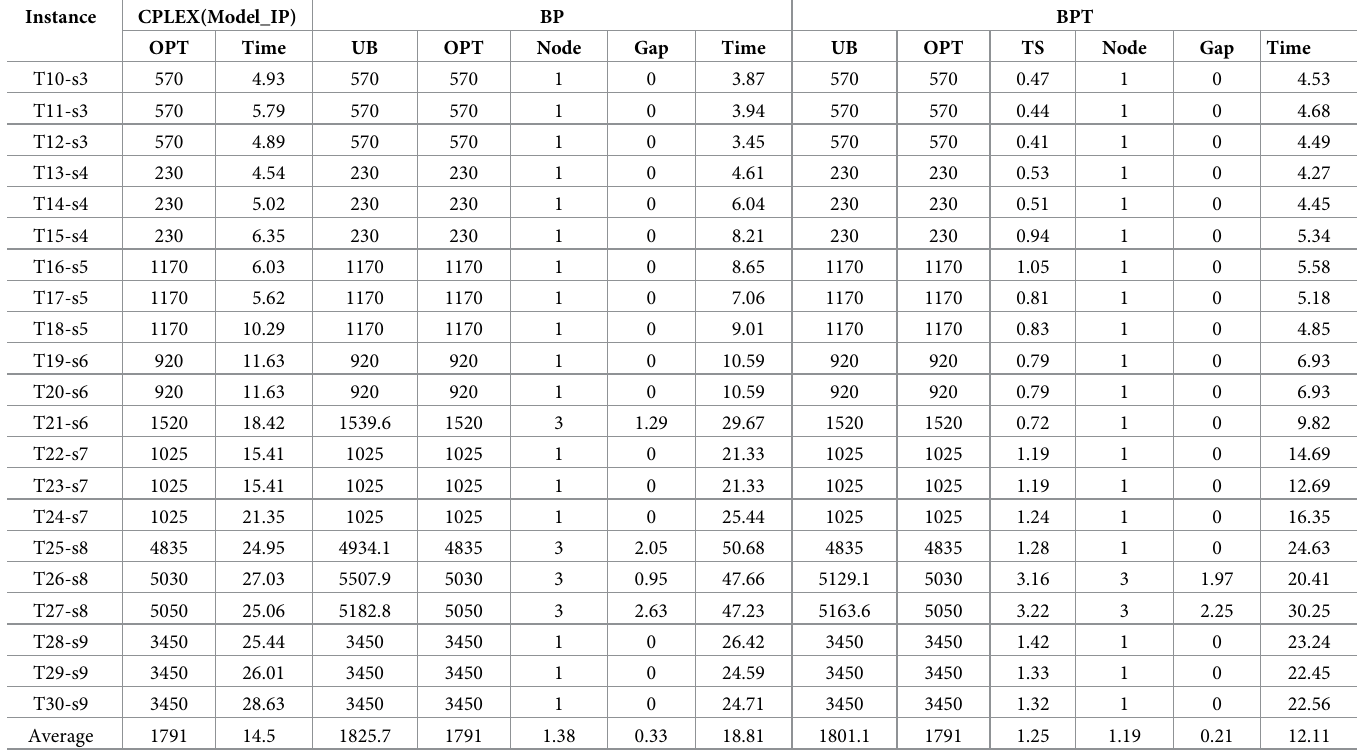
Table 7. The impact of more